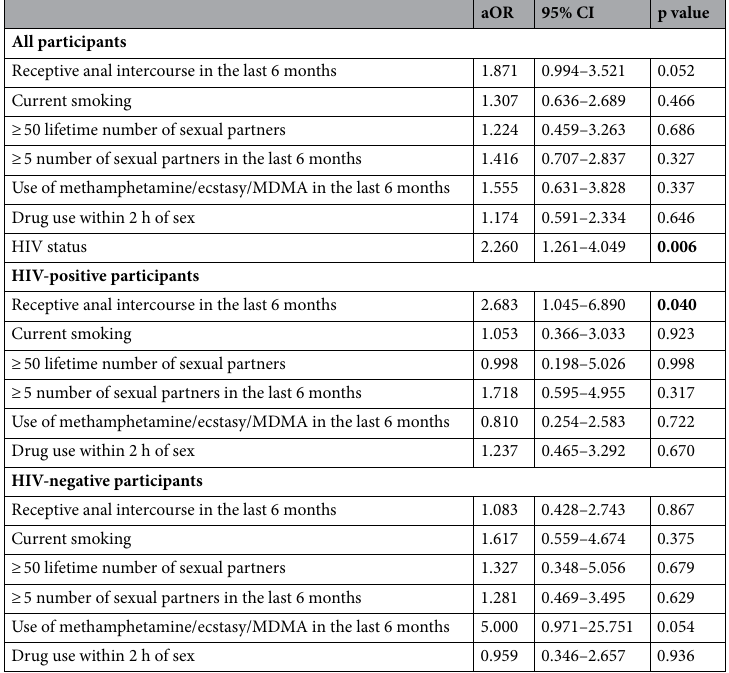
Table 3. Multivariable analysis of risk factors for any anal HPV infection. aOR adjusted odds ratio, CI confidence interval, Hosmer–Lemeshow goodness-of-fit statistics, p = 0.722. P value of < 0.05 was determined as statistically significant